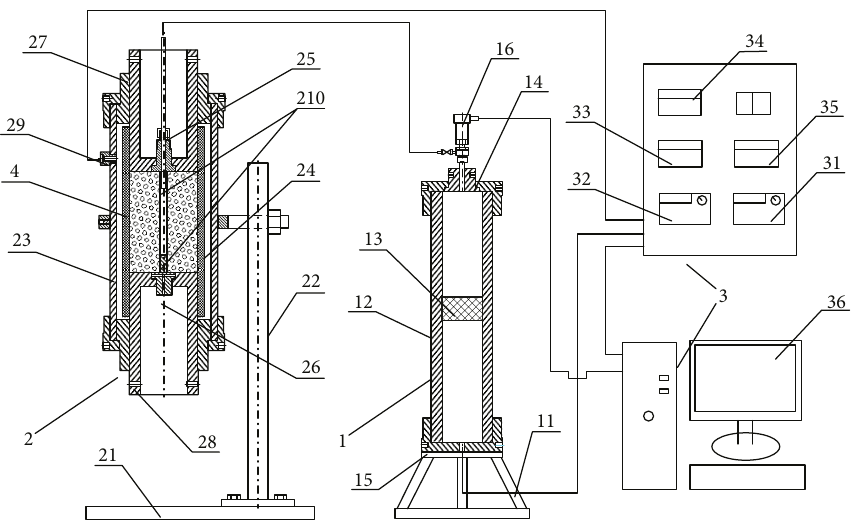
Figure 1: Schematic diagram of the fracturing experiment